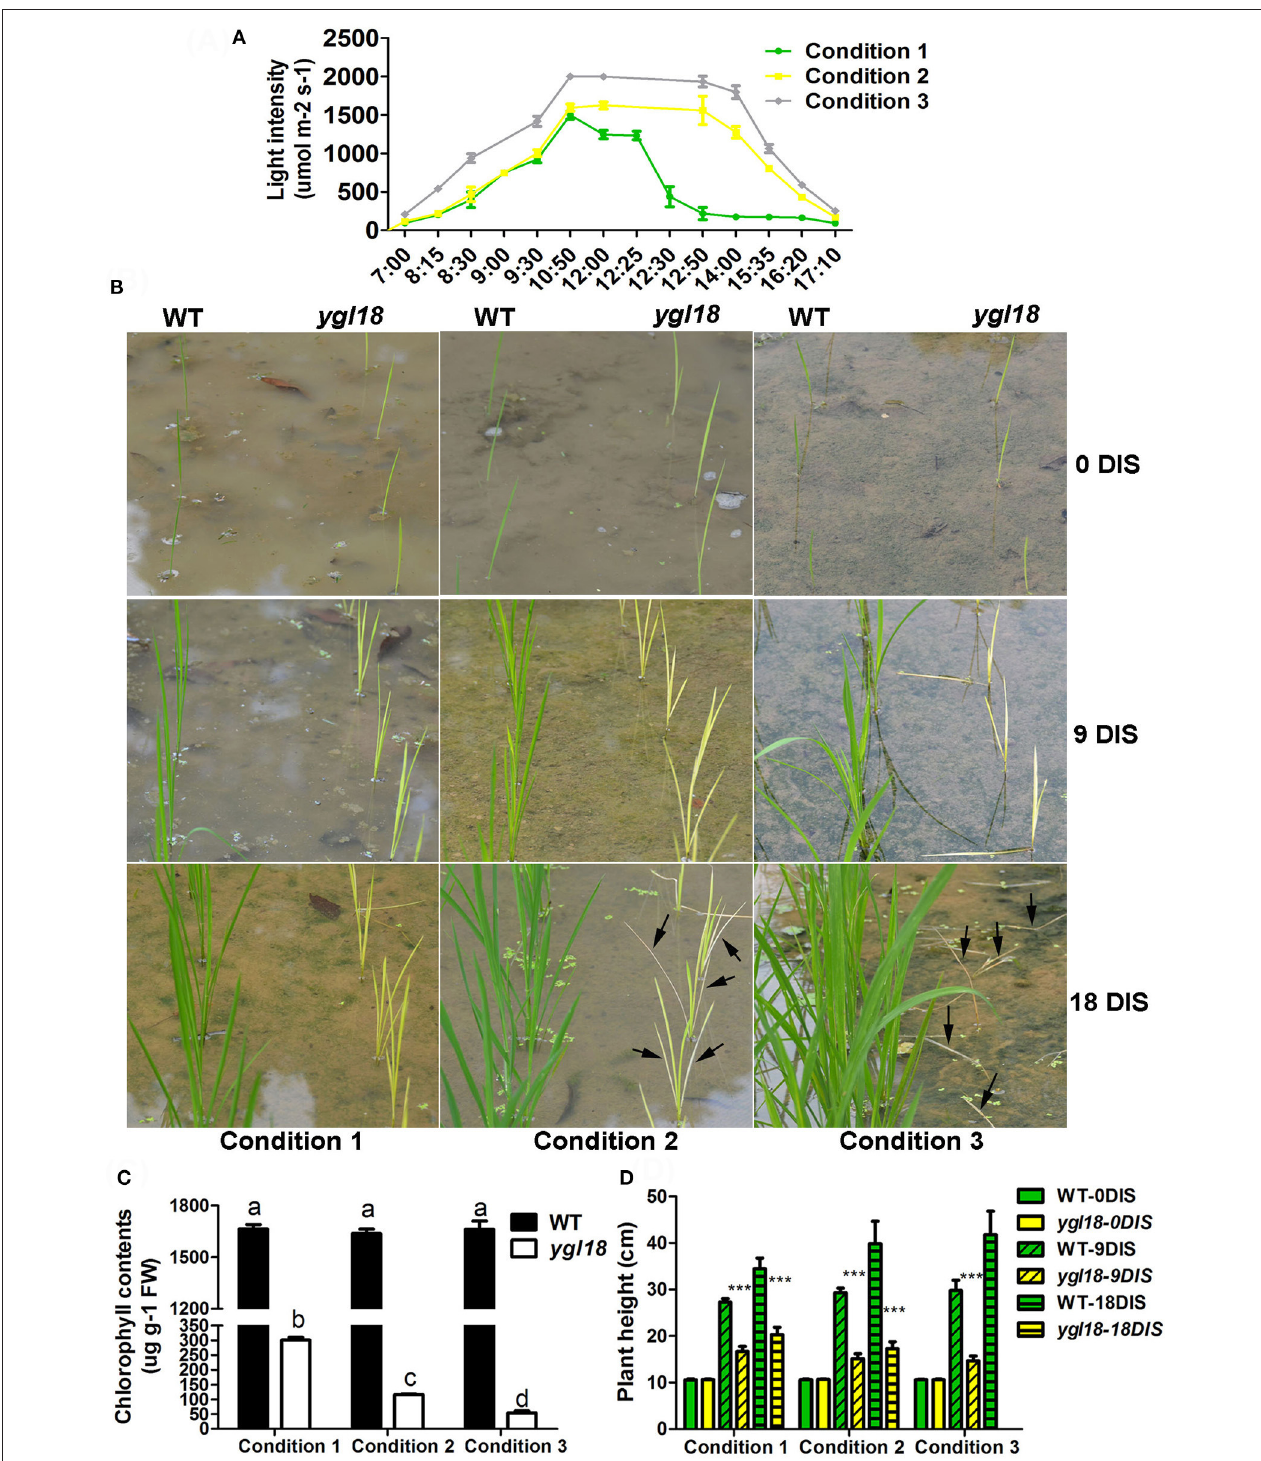
FIGURE 11 | Growth of the wild-type and ygl18 plants under different light conditions in the natural field. (A) Three different light conditions were generated by the solar motion and the tree shadow. Condition 1 had about 4 h’ time in sunlight (8:30–12:30), about 3 h’ light intensity over 1,000 µ mol m − 2 s − 1 , and a peak light intensity of about 1,500 µ mol m − 2 s − 1 . Condition 2 had about 8 h’ time in sunlight (8:30–16:20), about 5 h’ light intensity over 1,000 µ mol m − 2 s − 1 , and a peak light intensity of about 1,600 µ mol m − 2 s − 1 . Condition 3 had about 8 h’ time in sunlight (8:15–16:20), about 7 h’ light intensity over 1,000 µ mol m − 2 s − 1 , and a